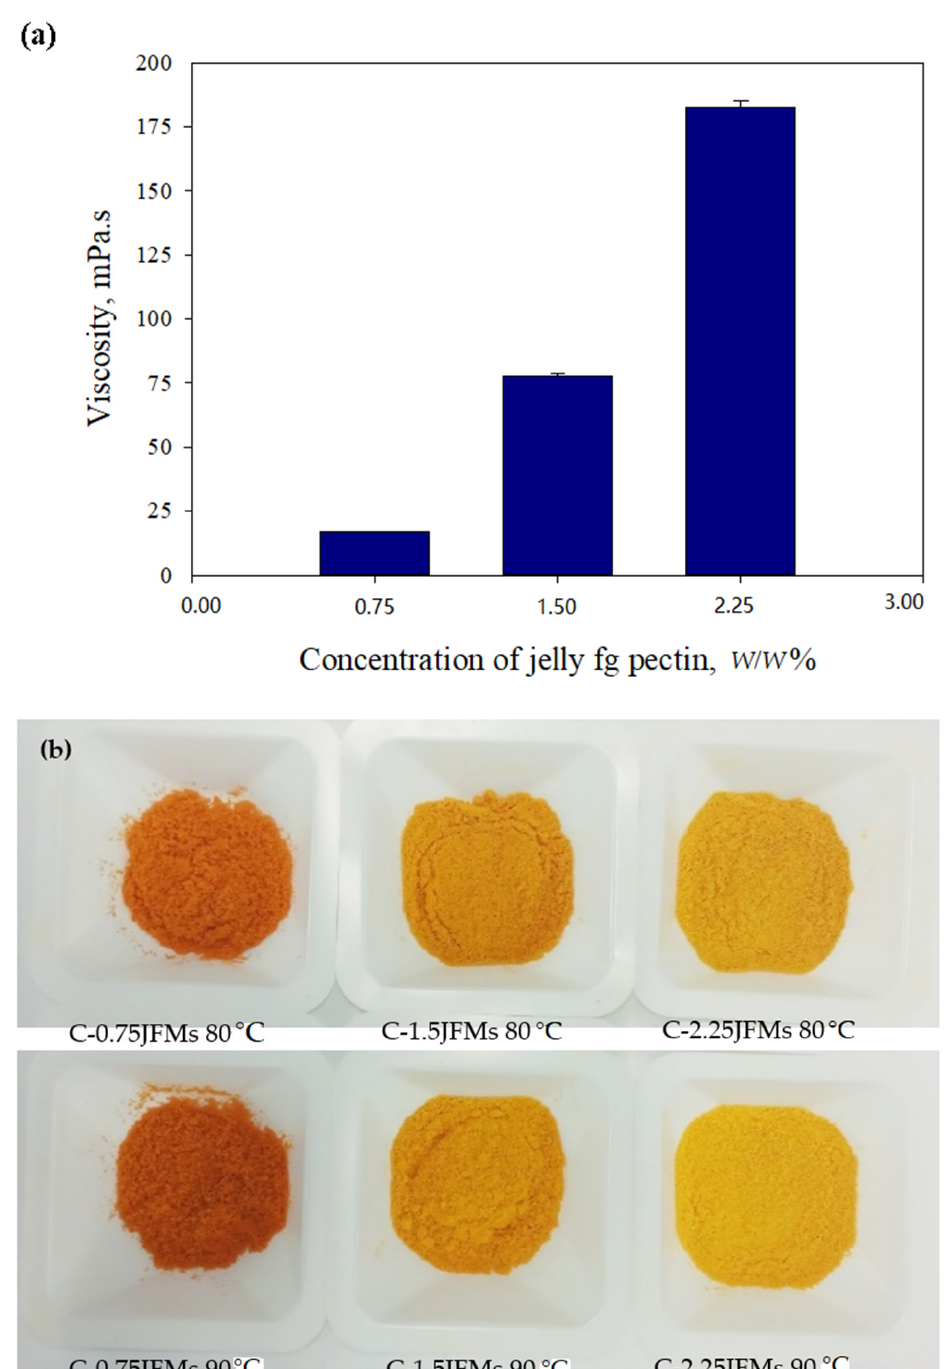
Figure 3. The viscosity of emulsion ( a ) before VSD and ( b ) dried powder of C-JFMs.